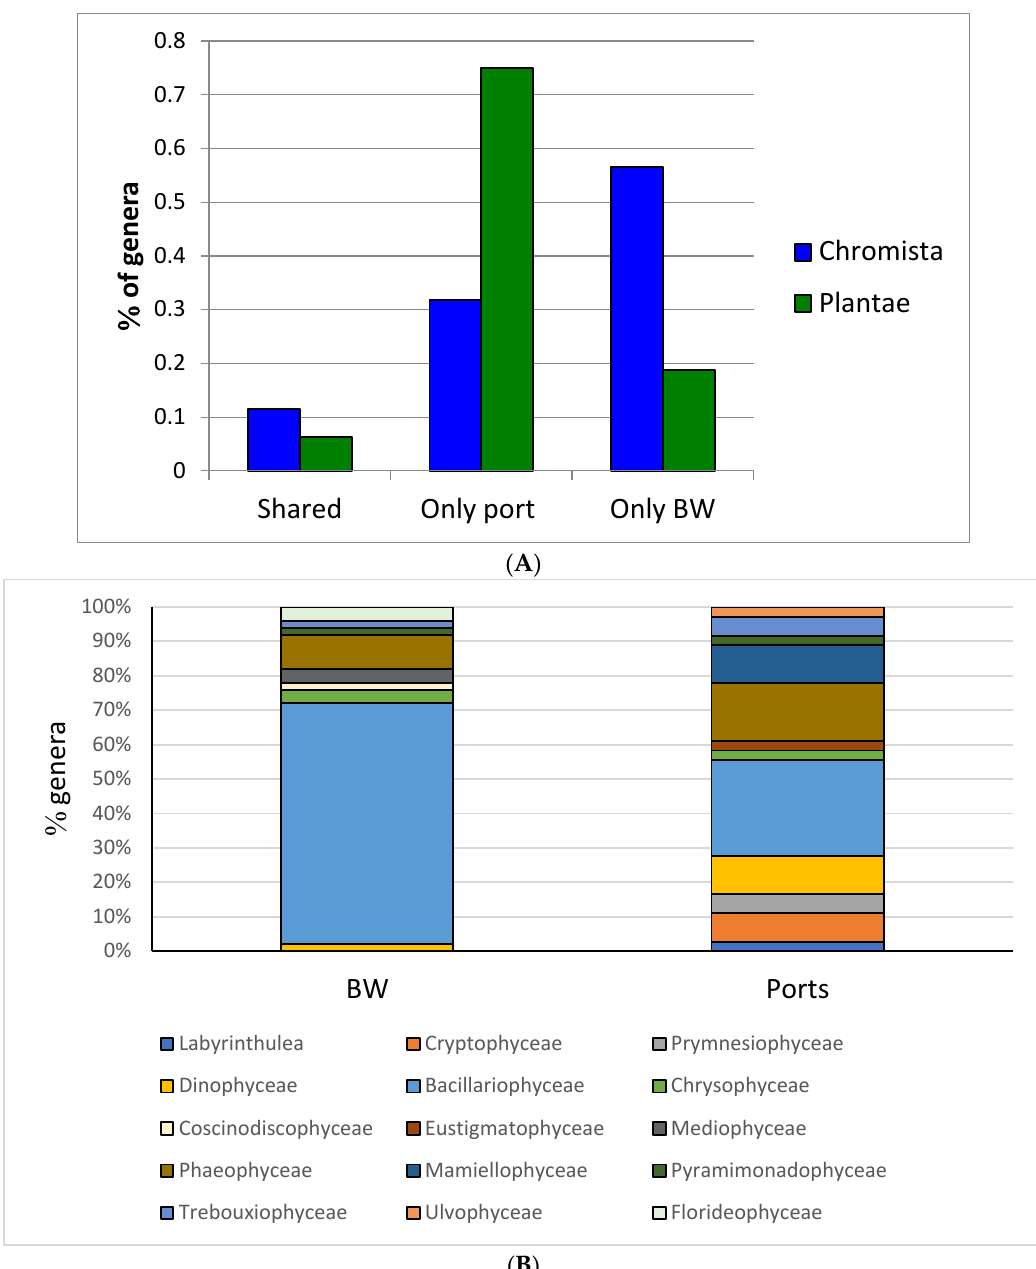
Figure 4. Comparison of algae found using NGS from ports and BW in Asturias region (SW Bay of Biscay). Results are presented as: ( A ) The proportion of genera of each type of alga (Chromista or Plantae) found only from ports, from BW, or shared between the two habitats; ( B ) taxonomic profile of BW and port water, as a proportion of genera by class of algae.